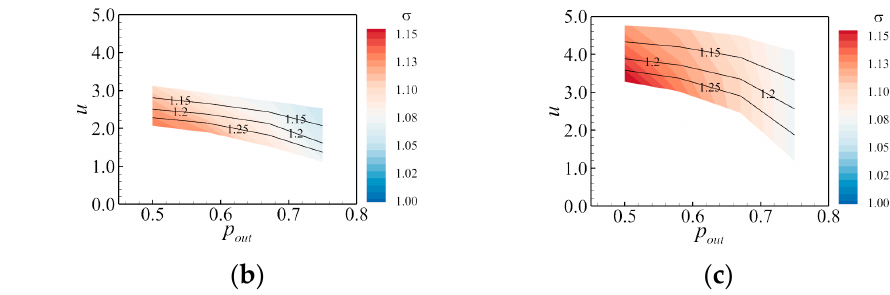
Figure 8. The distribution of bypass static pressure ratio under different VABI opening conditions ( α VABI = 25°): ( a ) A VABI = 0.8; ( b ) A VABI = 0.6; ( c ) A VABI = 0.4.